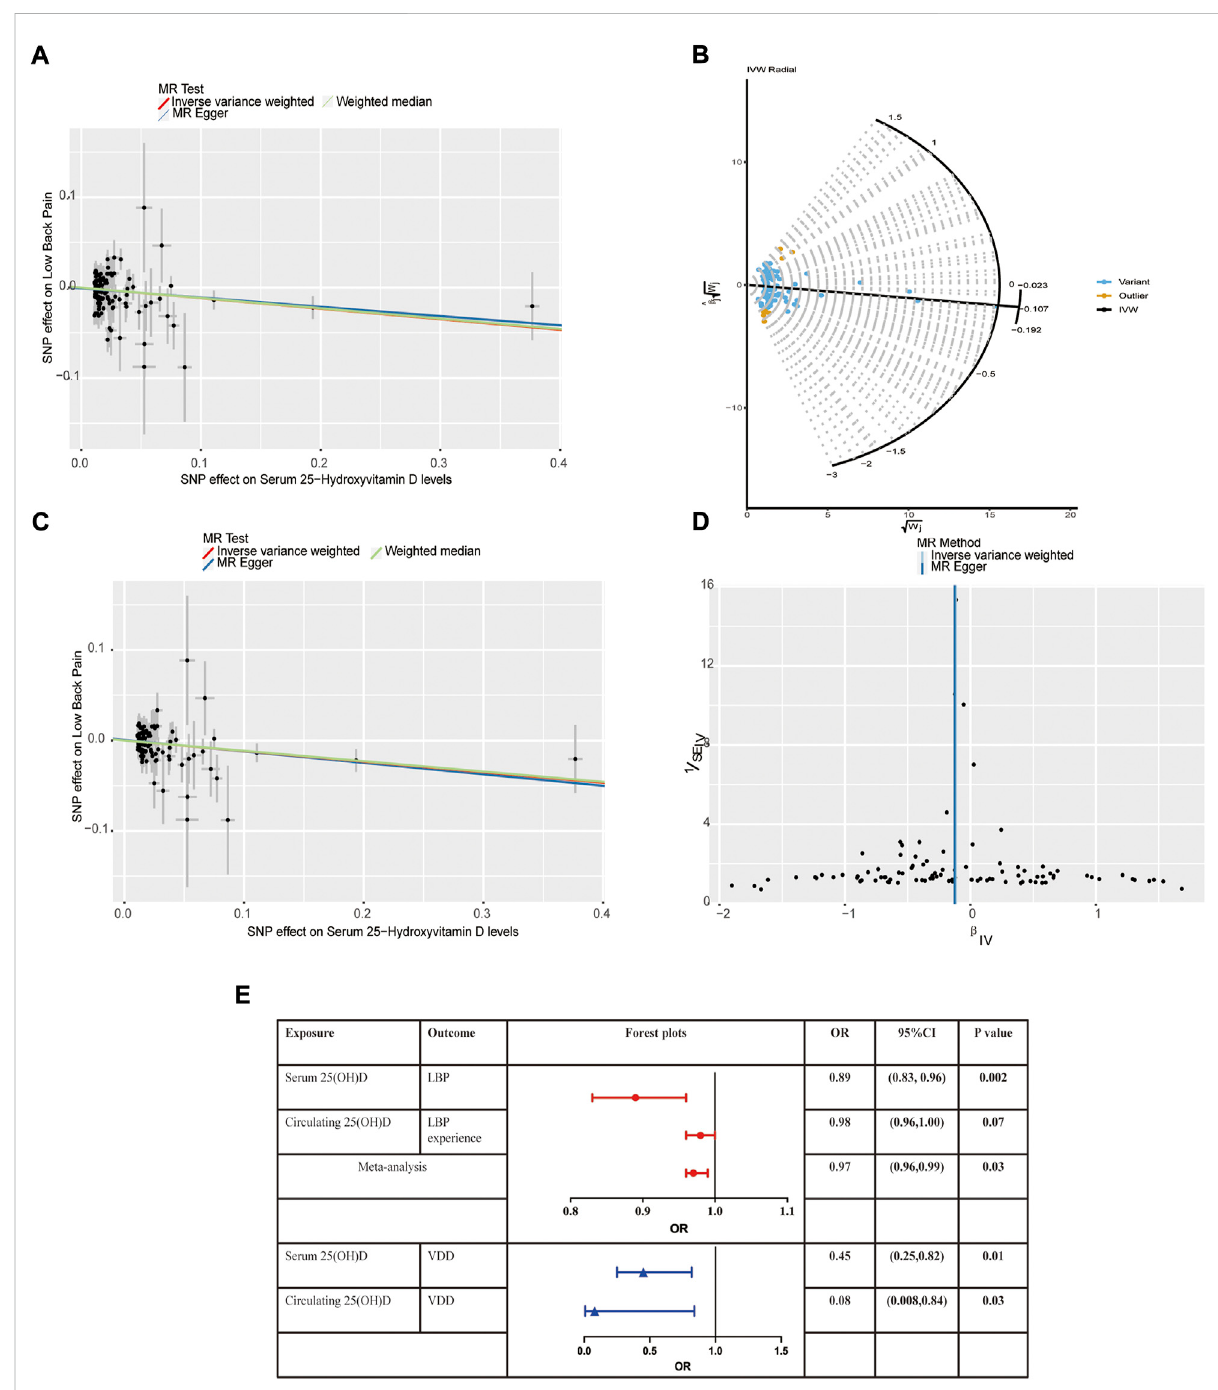
FIGURE 1 Mendelian randomization estimates from 25(OH)Don low back pain. (A) Scatter plot showing thecausality of serum 25(OH)Don low back pain previous to removing outliers identi fi ed by MR-PRESSO and MR Radial; (B) Outliers identi fi ed by MR Radial; (C) Scatter plot showing the causality of serum 25(OH)D on low back pain after removing outliers identi fi ed by MR-PRESSO and MR Radial. (D) Funnel plots; (E) Forest plots of the IVW